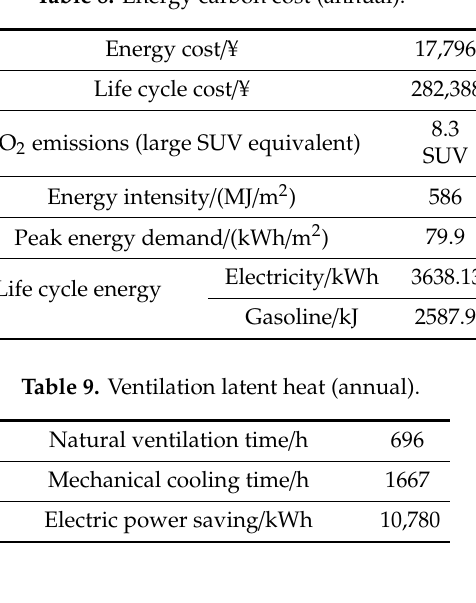
Table 8. Energy carbon cost (annual).